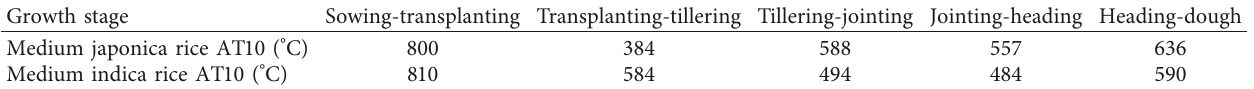
Table 4: AT10 thresholds of rice at different growth stages.